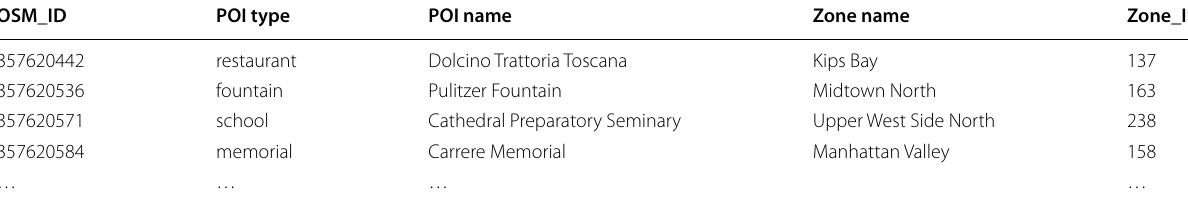
Table 2 Exemplifying overview of the POI data